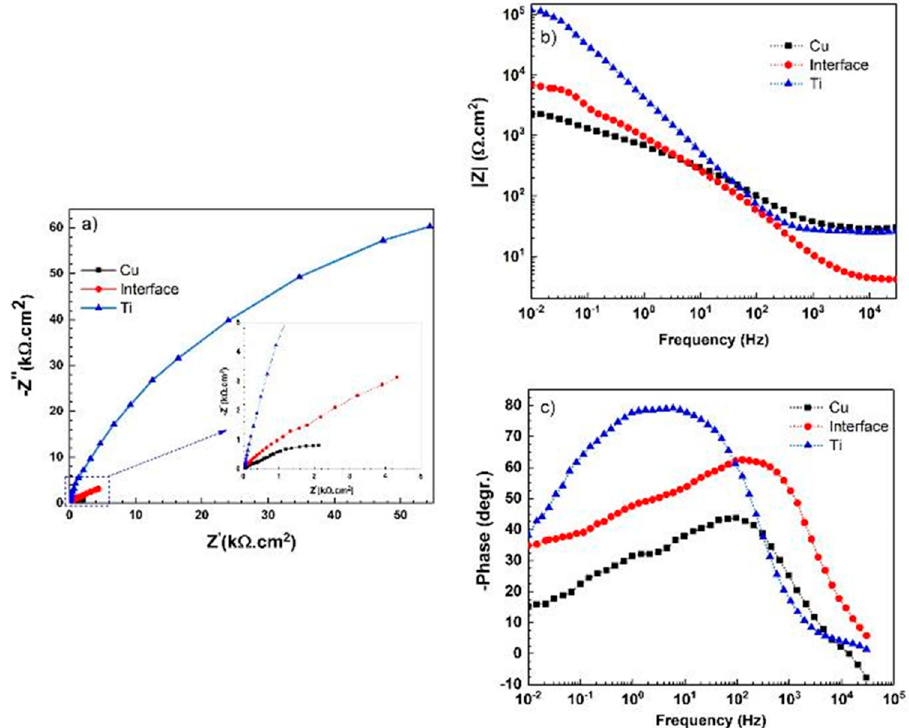
Figure 7. ( a ) Nyquist, ( b ) Bode |Z| and ( c ) Bode-phase diagrams resulting from electrochemical impedance spectroscopy of Ti, Cu and weld interface in 3.5 wt.% NaCl solution; 10 mV amplitude around E ocp with a frequency range of 30 kHz–10 MHz.